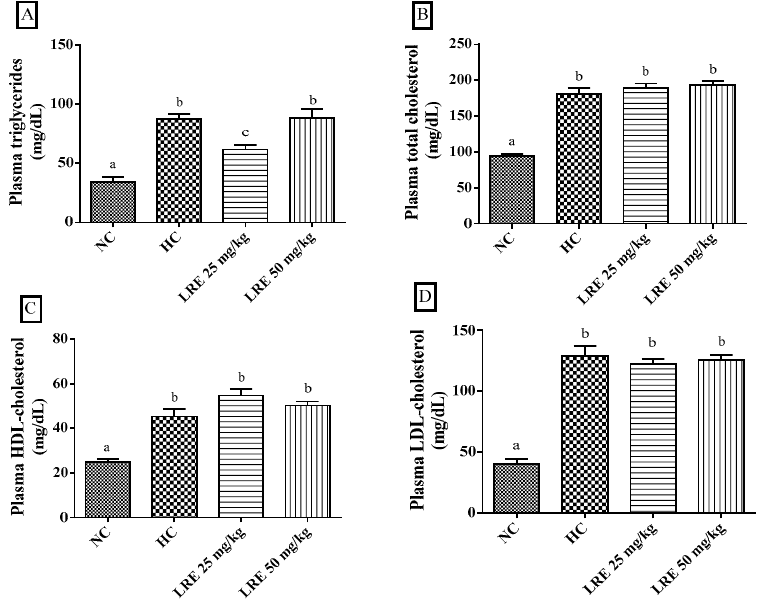
Figure 2. Plasma levels of triglycerides (TG) ( A ), total cholesterol (TC ( B ), high-density lipoprotein-cholesterol (HDL-c) ( C ) and low-density lipoprotein-cholesterol (LDL-c) ( D ) of hamsters submitted to experimentally induced dyslipidemia and treated with LRE. Each column represents mean ± SEM (standard error of the mean) of 7-9 animals/group. Two mean values that are not indicated with the same letter are significantly different from each other ( p < 0.05). One-way analysis of variance (ANOVA), followed by Tukey's test.